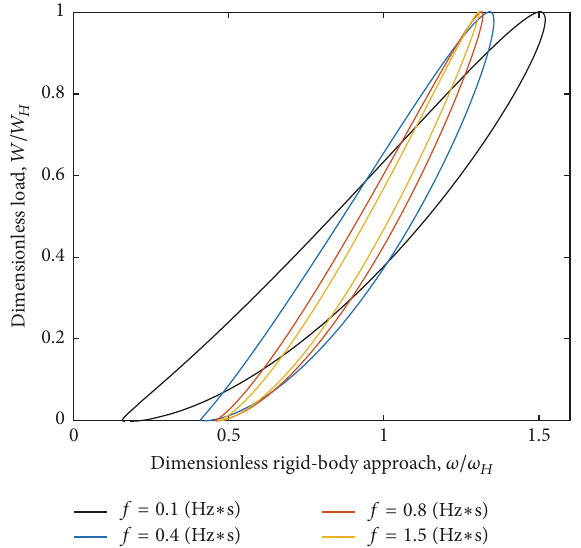
Figure 12: Hysteresis loops for various loading frequencies, Zener